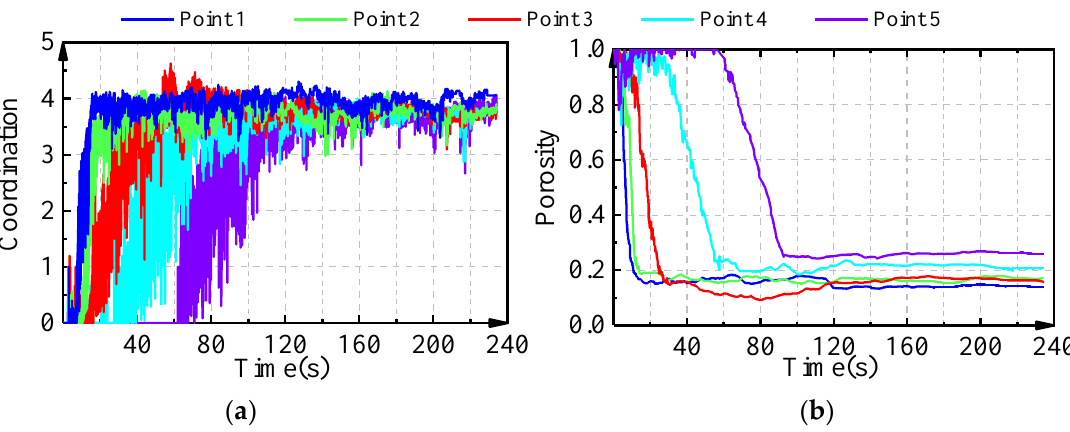
Figure 4. Compaction change of accumulation after blasting: ( a ) coordination; ( b ) porosity.